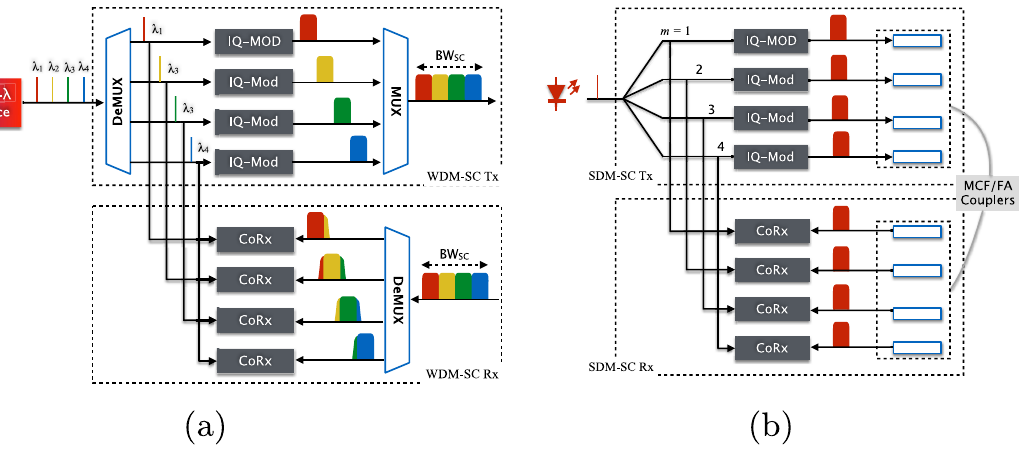
Figure 11: (a) Schematic of a spectral superchannel transceiver. Multiwavelength source can take the form of optical frequency comb or laser bank. The deMUX at the input side is not needed in the later case. (b) Schematic of a spatial superchannel transceiver for a single wavelength carrier. Only one polarization path is shown for